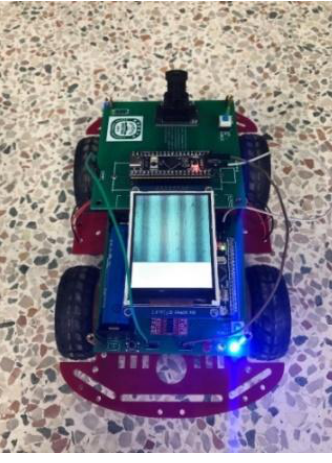
Figure 7 . Receiving terminal platform